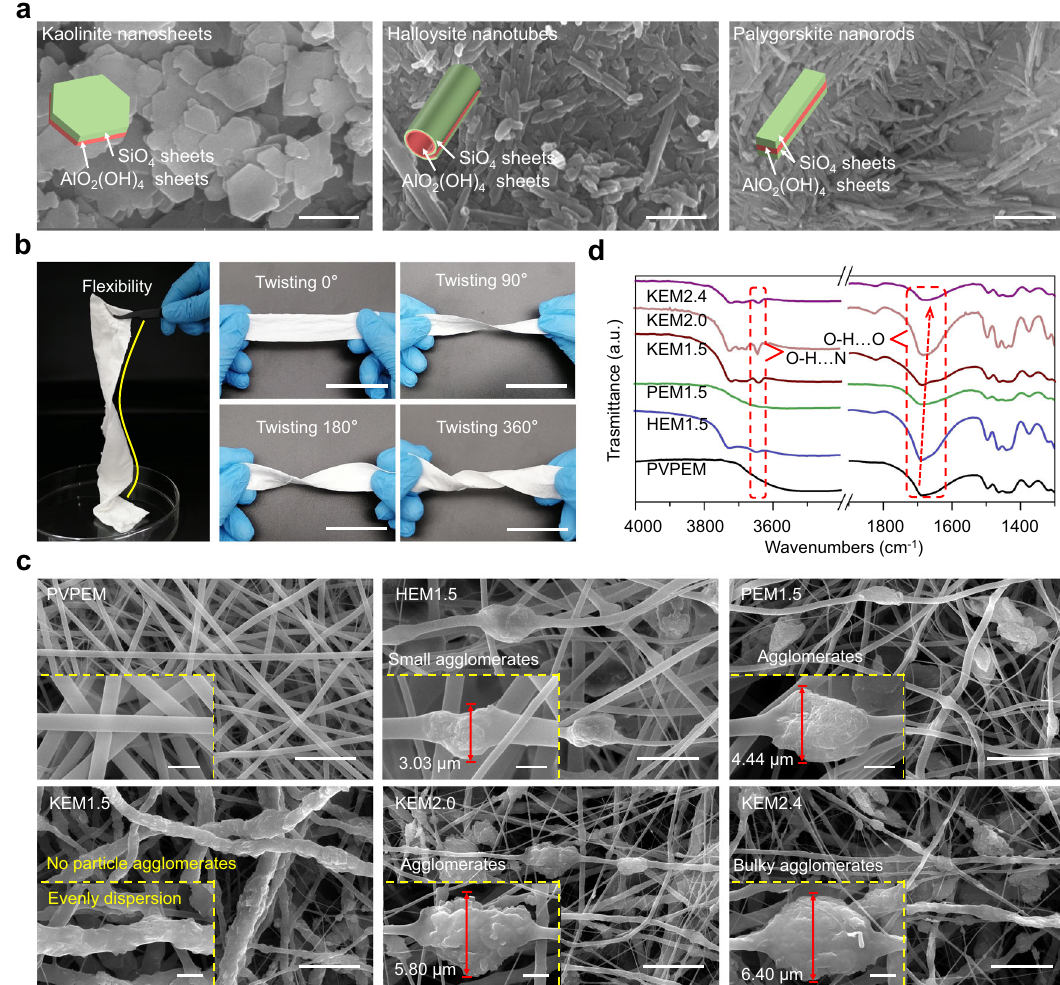
Fig. 1 Fabrication, surface morphology and characteristics of the nanoclay membranes. a SEM images of kaolinite, halloysite and palygorskite, respectively. Scale bar, 500 nm. b Photographs of clay-membrane strips with different extents of in situ twisting. Scale bar, 10 cm. c SEM images of PVPEM, HEM 1.5 , PEM 1.5 , KEM 1.5 , KEM 2.0 , and KEM 2.4 , respectively. Scale bar, 10 μ m. The insets in ( c ) are the corresponding magni fi ed SEM images. Scale bars in the insets of ( c ), 2 μ m. d The localized magni fi ed FT-IR spectra of PVPEM, HEM 1.5 , PEM 1.5 , KEM 1.5 , KEM 2.0 and KEM 2.4 , respectively. Data were analyzed from at least three independently experiments in ( a ) and ( c ). Source data are provided as a Source Data fi